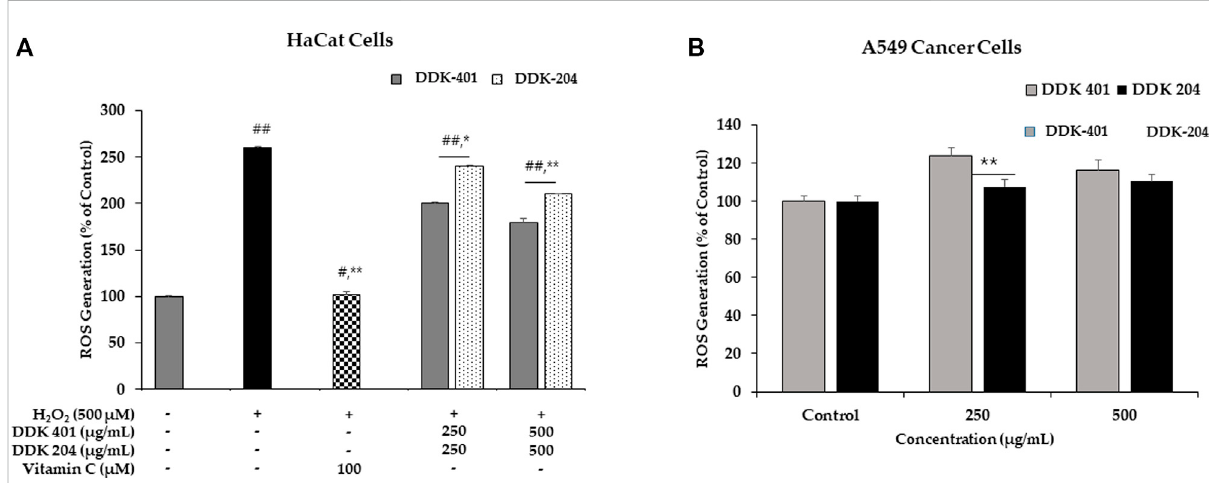
FIGURE 6 (A) Reactive oxygen species (ROS) inhibition by DDK-401 and DDK-204 in HaCaT cell lines treated with H 2 O 2 . The graph shows the mean ± SD value of three repetitions. * p < 0.05 and ** p < 0.01 indicate signi fi cant differences from the control groups; # p < 0.05 and ## p < 0.01